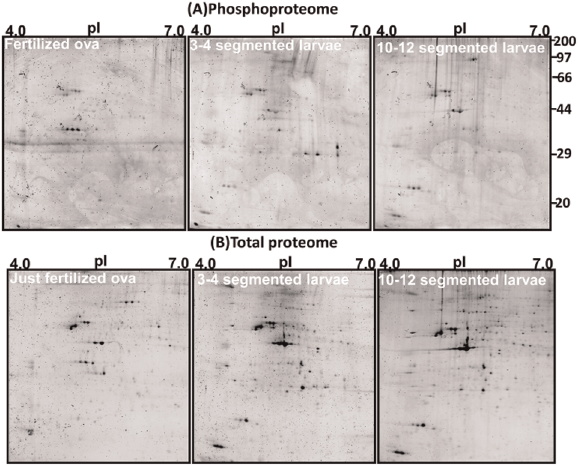
Figure 5. A close view of stage specific total proteins (A) and phosphoproteins (B) expressed in fertilized ova, and larvae of Neanthesarenaceodentata.